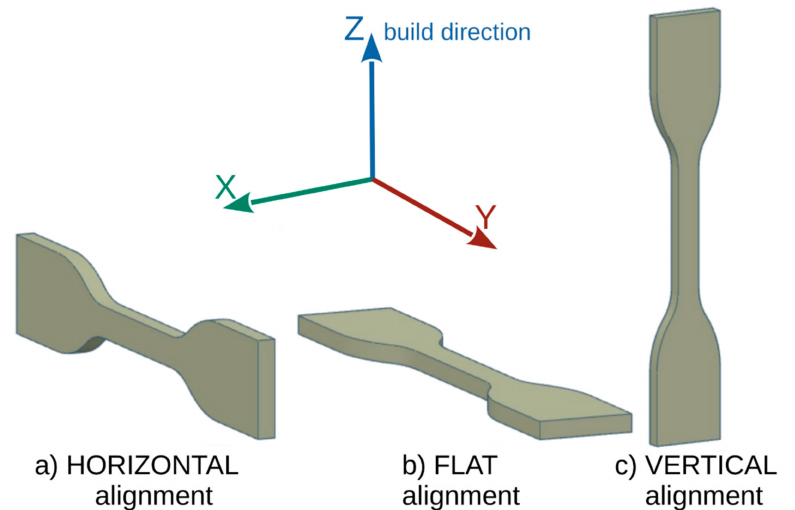
Figure 4. Orientation of the samples on the worktable: ( a ) “horizontal”, ( b ) “flat”, ( c ) “vertical”.